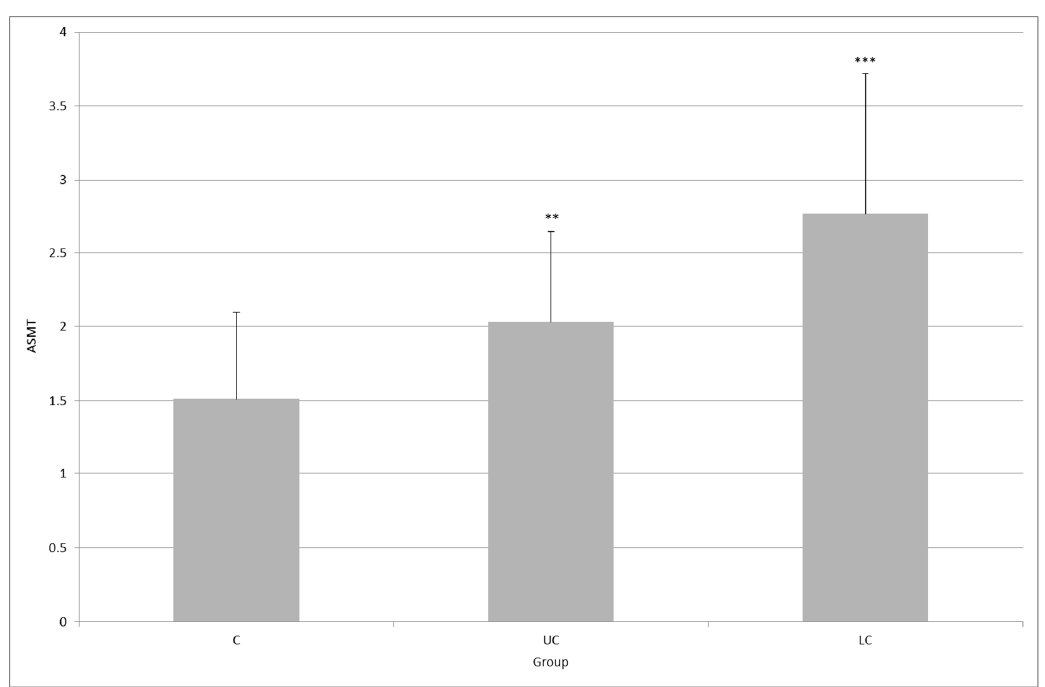
Figure 3. Expression of N -acetylserotonin methyltransferase (ASMT) in the colonic mucosa of healthy subjects (C), and in patients with ulcerative colitis (UC) and lymphocytic colitis (LC); ** p < 0.01, *** p < 0.001; the difference between UC and LC groups was statistically significant ( p < 0.01).